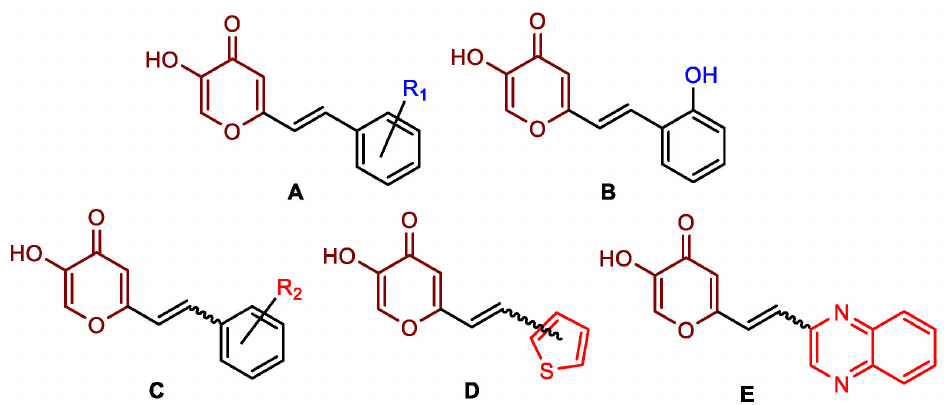
Figure 2. Representative resveratrol–maltol target